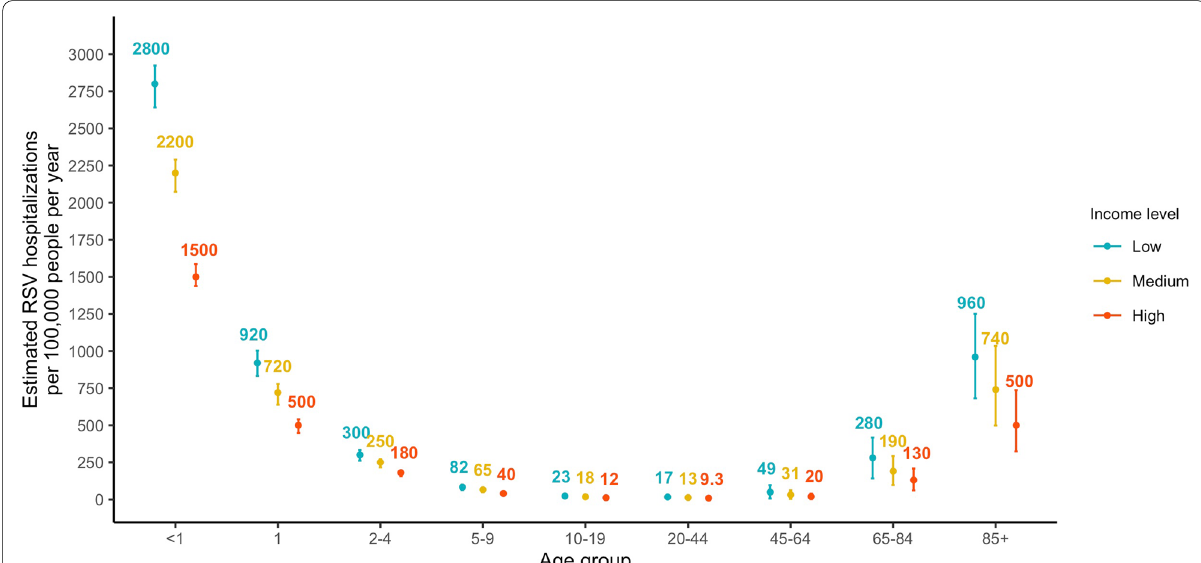
Fig. 1 Estimated annual RSV-attributable respiratory hospitalization rates by age and SES group, July 2005—June 2014. The color texts show the mean estimates of RSV-attributable respiratory hospitalization rates per year in each age and SES group. The error bars indicate the 95% credible intervals of the estimated RSV-attributable respiratory hospitalization rates. Color blue, yellow, and red correspond to the estimates in populations from low, medium, and high SES ZIP codes,